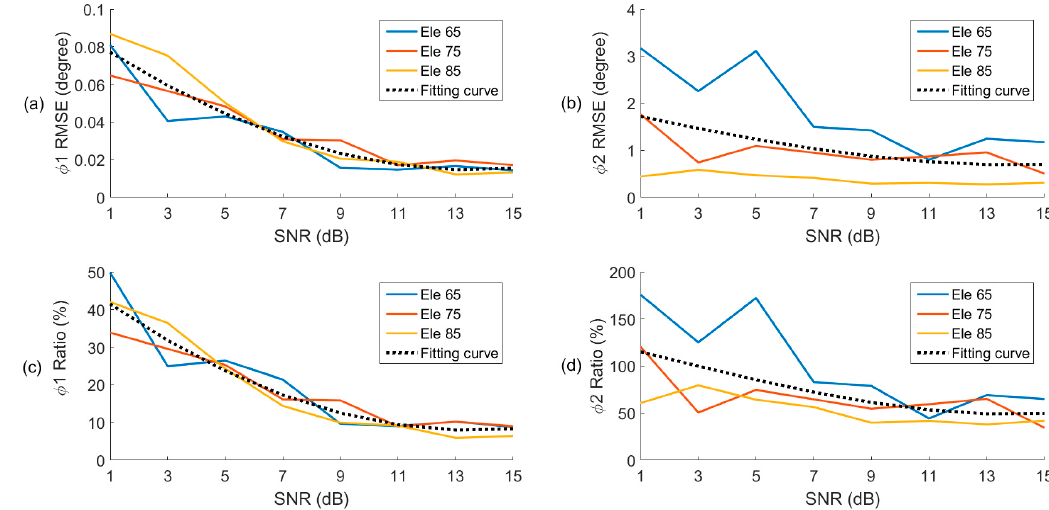
Figure 11. Root-mean-square error (RMSE) of angles ( a ) ϕ 1 and ( b ) ϕ 2 derived from DDMs with different SNRs and receiver’s elevations. The ratio of RMSE to the corresponding amplitude of the oscillation of angles ( c ) ϕ 1 and ( d ) ϕ 2 .